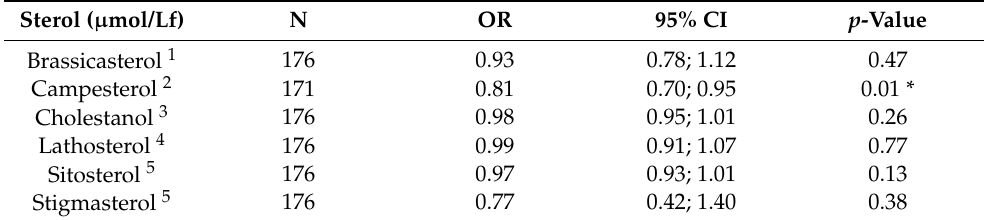
176 0.77 0.42; 1.40